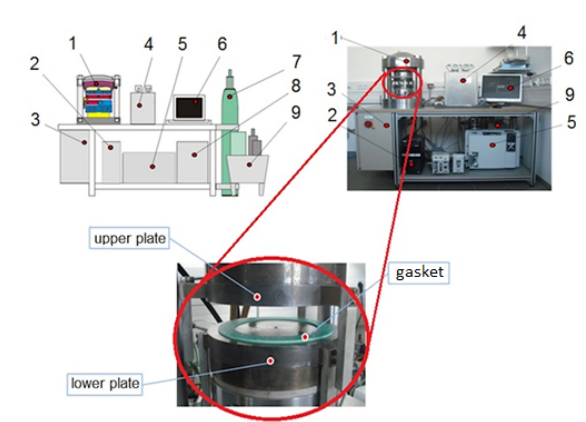
Figure 1: Test rig to determine materials properties of gasket; 1- hydraulic press, 2 – computer, 3 – control board, 4 – differential pressure units, 5- helium detector, 6 – screen, 7 – helium reservoir, 8 – cooling unit of the hydraulic press, 9 – oil pump of the hydraulic